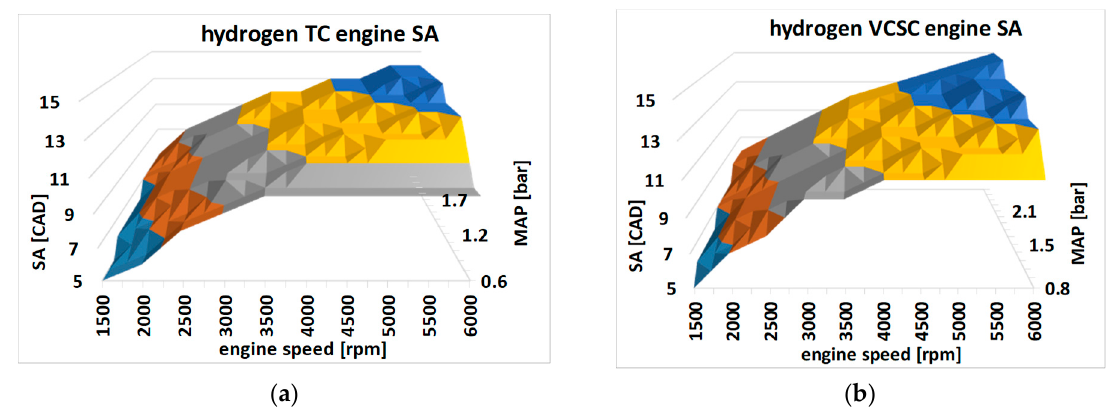
Figure 2. SA maps of the TC ( a ) and VCSC ( b ) hydrogen ‐ fueled engine vs. engine speed and MAP.